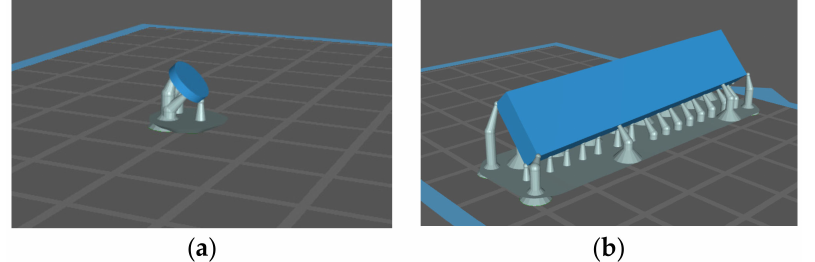
Figure 1. CAD design of specimens used in antimicrobial activity tests ( a ) and in superficial roughness measurement ( b